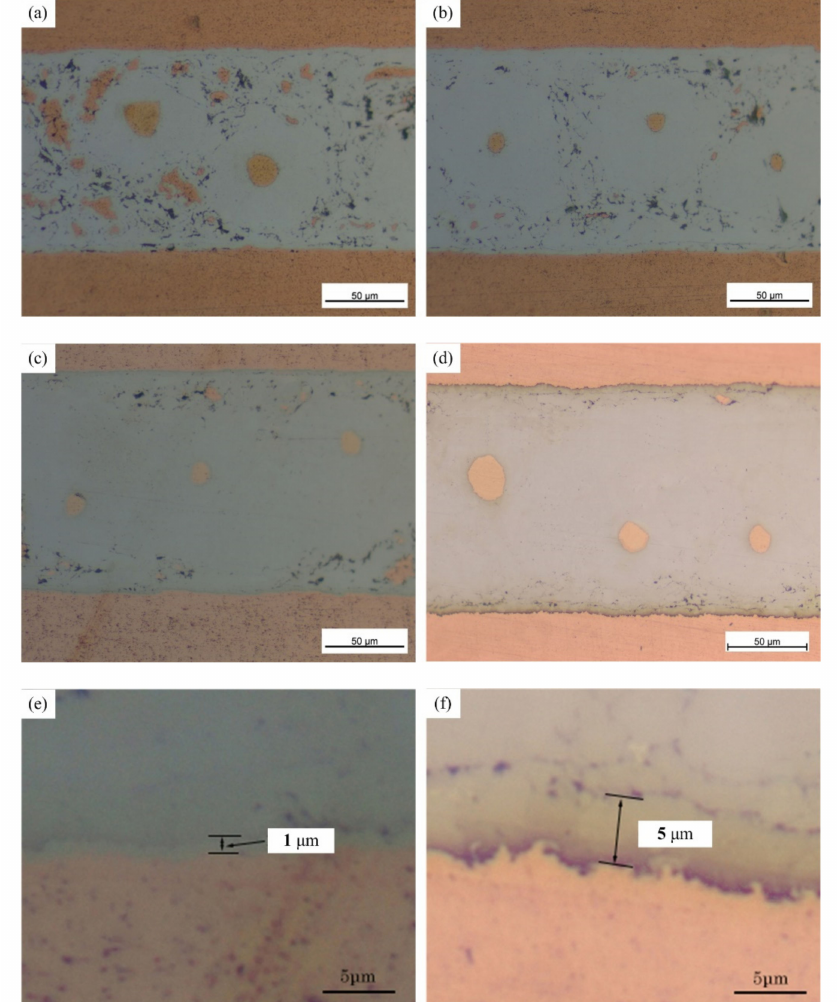
Figure 7. Optical microscope image of the joints at 100 ◦ C. ( a ) Holding time of 10 h; ( b ) Holding time of 20 h; ( c ) Holding time of 30 h; ( d ) After annealing treatment of Cu substrates with holding time of 30 h; ( e ) Interface between copper substrate and the intermediate layer in Figure 4c; ( f ) Interface between copper substrate and the intermediate layer in Figure